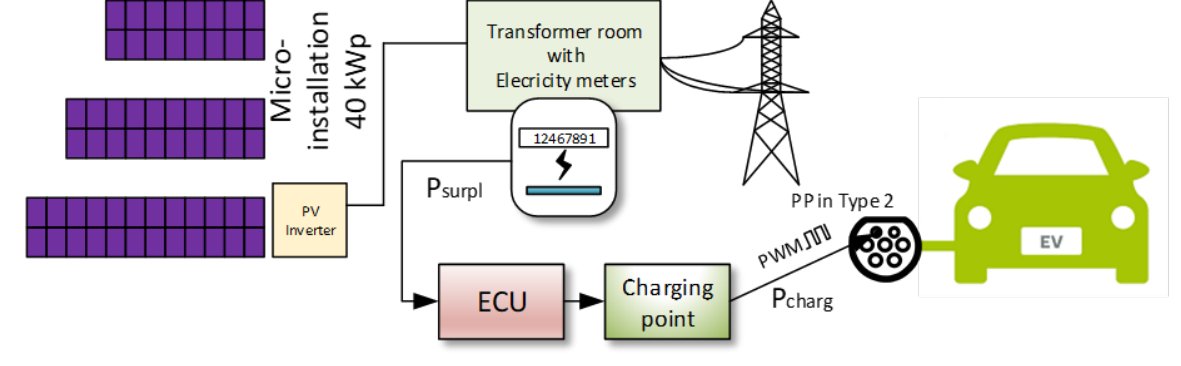
Figure 8: The conceptual diagram of the electronic control system